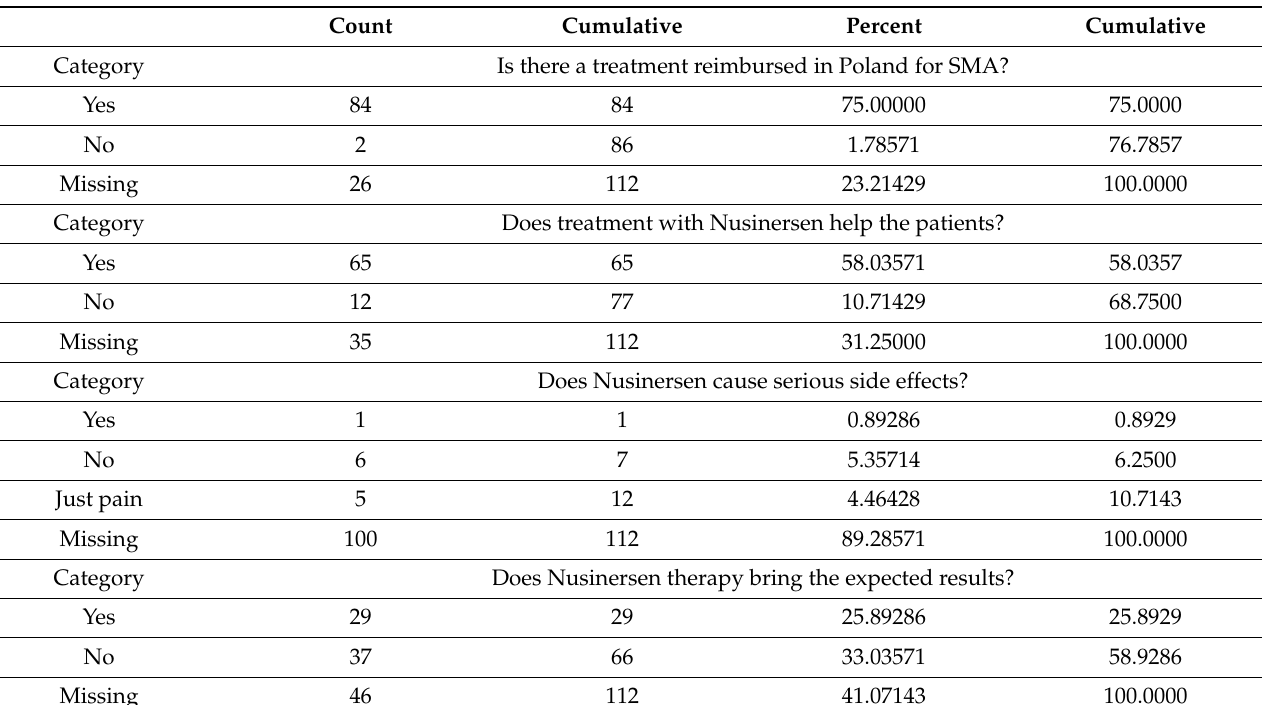
Table 4. Information and statements found in the analyzed